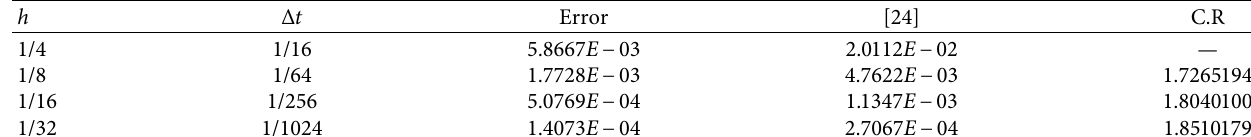
Table 1: Error of Y at diferent step sizes.